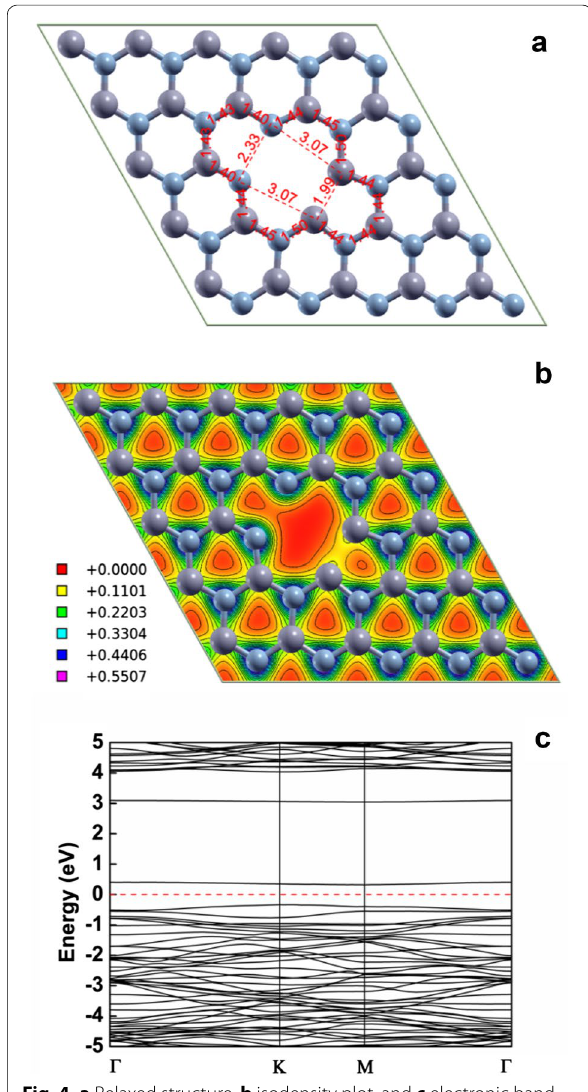
Fig. 4 a Relaxed structure, b isodensity plot, and c electronic band structure of h‑BN with 2V BN . The Fermi level is set to be